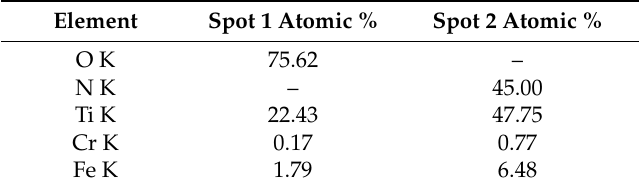
Figure 6. SEM morphologies of the fretting damages on the Ti/TiN multilayer film deposited on Table 1. Energy dispersive spectroscopy (EDS) analysis results in spots 1 and 2, as indicated in Figure 6a. Element Spot 1 Atomic % Spot 2 Atomic % O K 75.62 N